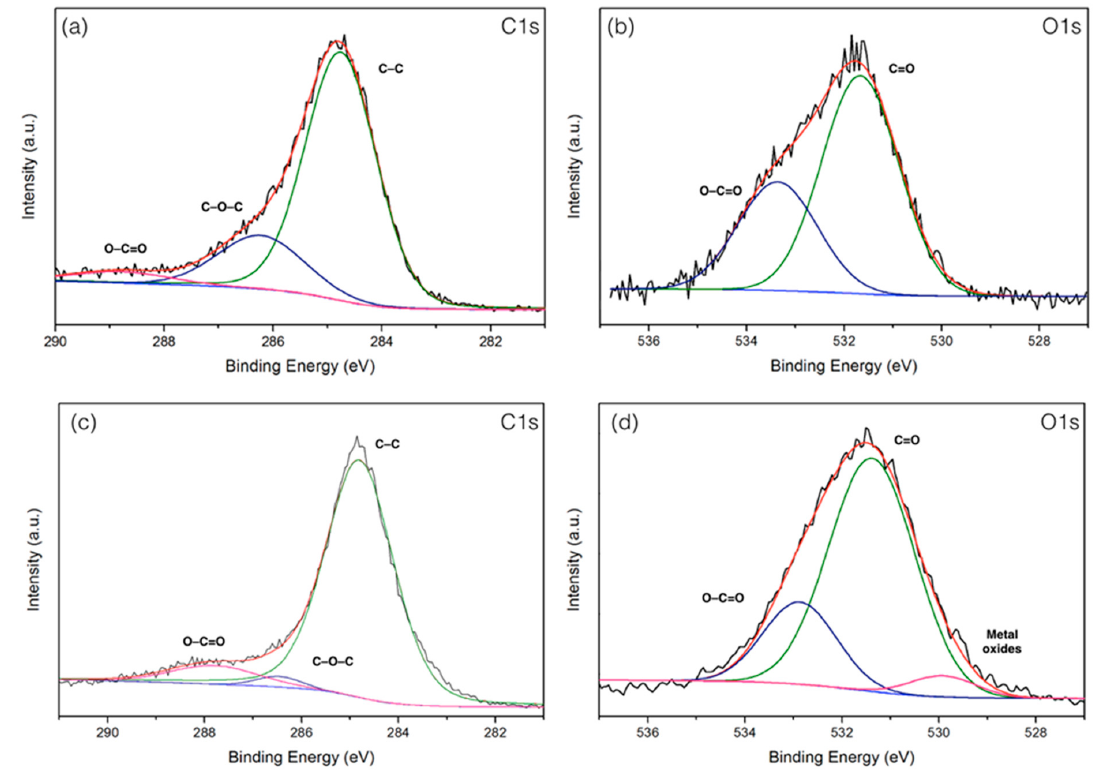
Figure 6. X-rayphotoelectronspectroscopy(XPS)spectraof( a,b )carbonizedPMFsand( c,d Figure 6. X-ray photoelectron spectroscopy (XPS) spectra of ( a,b ) carbonized PMFs and ( c,d ) PMFC- 700-6-2:1.